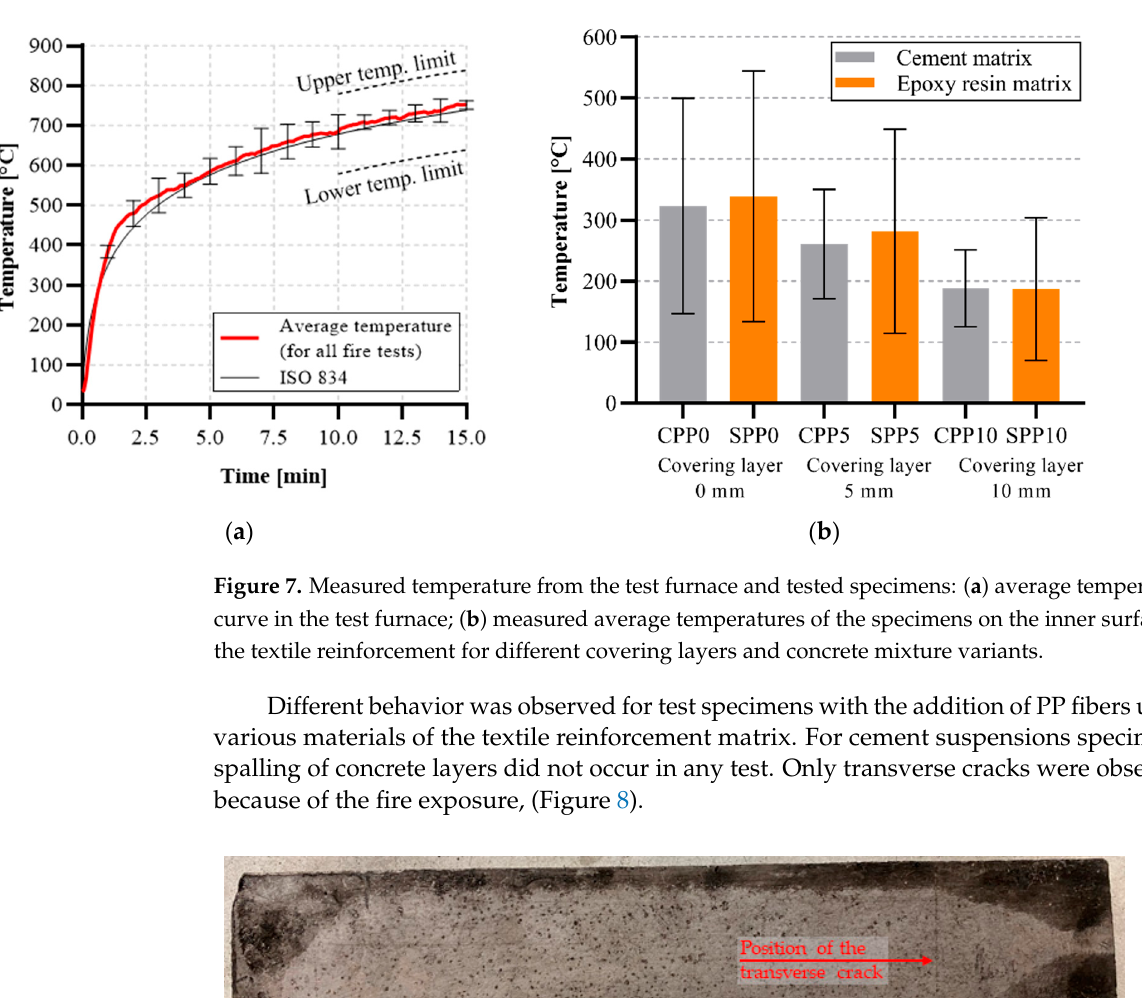
Figure 8. Test specimen with 10 mm covering layer and an addition of PP fibers in concrete mixture (HPC mixture No. 1)—the development of a transverse crack during a fire test.